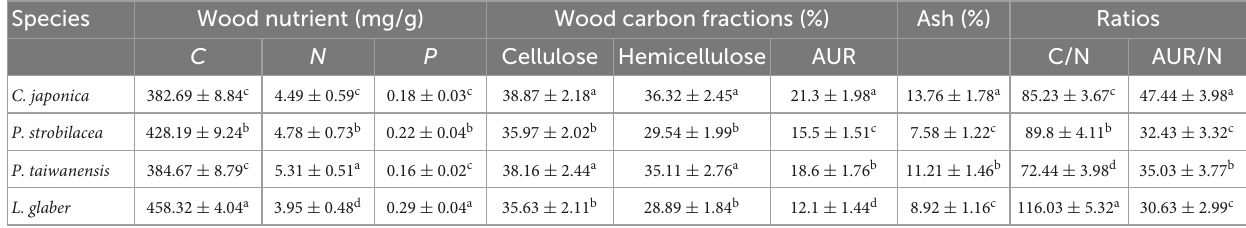
TABLE 1 Initial physiochemical properties and carbon fractions of the four types of wood (means ± SEs, n = 6). Species Wood nutrient (mg/g) Wood carbon fractions (%) Ash (%) Ratios C N P Cellulose Hemicellulose AUR